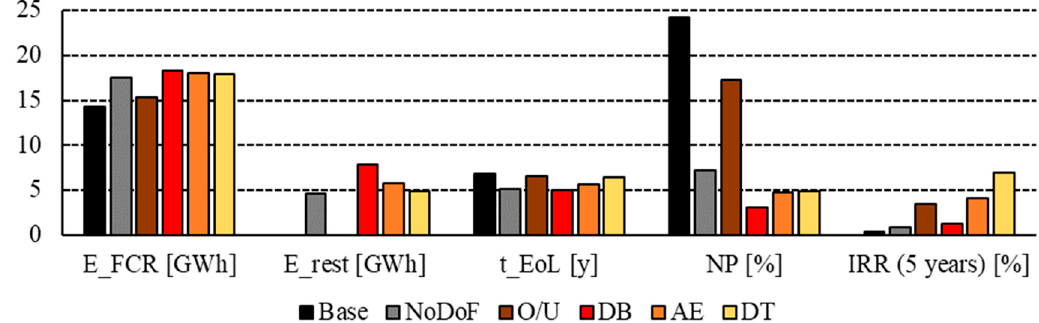
Figure 9. Summary of the results of the yearly simulations. Absolute value of energy for FCR (E_FCR), absolute value of energy for SoC restoration (E_rest), the BESS expected life (t_EoL), the ratio of NP with respect to total energy requested for FCR, the IRR at 5 y are shown for each of the Cases: base case, no DoF case, over / under-regulation case (O / U), dead-band case (DB), available energy case (AE) and double threshold case (DT).